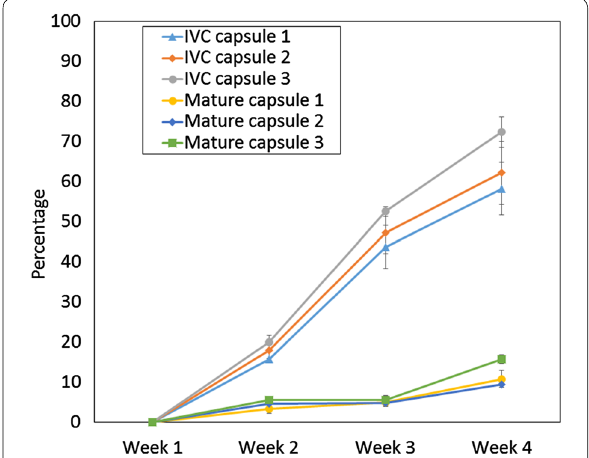
Fig. 2 Germination of mature seeds from mature capsules versus seeds of in vitro-collected near-mature capsules of Angraecum magdalenae , recorded over a 4-week period. Means of four